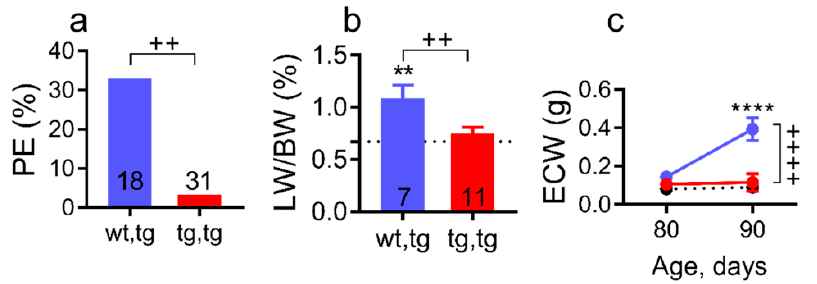
Figure 3. Cardiac corin-Tg(i) overexpression reduces pleural effusion, edema, and systemic water retention in female mice with DCM. ( a ) Pleural effusions (PE) prevalence; bars represent percent affected mice analyzed by Fishers exact test and ( b ) lung weight-to-body weight ratio (LW/BW) at 90 days of age, analyzed by one-way ANOVA with Newman–Keuls multiple comparison test. The number of mice per group is shown and the values for control mice without DCM (corin-WT/WT, wt,wt) are indicated by dotted lines ( n = 8). ( c ) Age-related changes in extracellular water (ECW). Experimental groups were: Corin-Tg(i)/DCM ( ● , tg,tg, n = 6–11), corin-WT/DCM ( ● , wt,tg, n = 20 – 25), and WT (dotted lines, n = 15–18) mice. Data are represented as mean ± SE; **** p < 0.0001, ** p < 0.01 (tg,tg or wt,tg vs. wt,wt); ++++ p < 0.0001, ++ p < 0.01 (tg,tg vs. wt,tg).